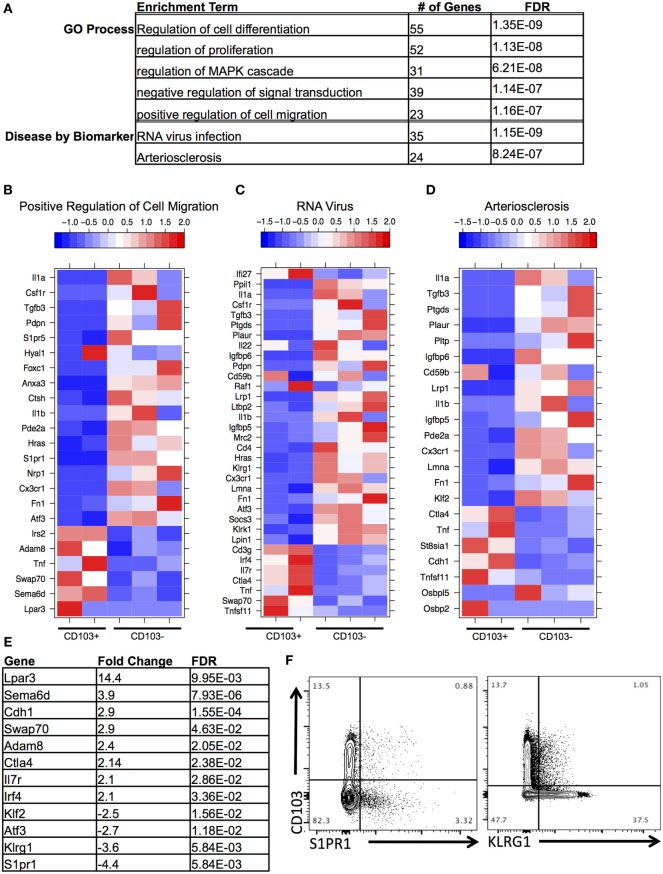
Distinct transcriptional profile of brain CD103+ CD8 T cells relative to brain CD103− CD8 T cells. (A) After conducting differential gene expression analysis between brain CD103+ and brain CD103− CD8 T cells, the genes with a fold change >2, FDR <5%, and mean RPKM >1 were input into MetaCore for functional enrichment. Of the 239 genes input, the following terms with FDR <5% were extracted from the categories “Disease by Biomarker” and “GO Process.” (B) Heatmap of genes under GO process term “Positive regulation of cell migration.” (C) Heatmap of genes under Disease term “RNA virus.” (D) Heatmap of genes under enrichment term “Arteriosclerosis.” Individual replicates in heatmap are pooled from n = 5 mice. Values in legend are scaled values representative of RPKM. Red indicates a highly expressed gene, and blue indicates a gene with a low expression value. (E) Table of fold changes and false discovery rate for genes relevant to tissue residence and memory phenotype. (F) Flow cytometry for differential expression of S1PR1 and KLRG1.